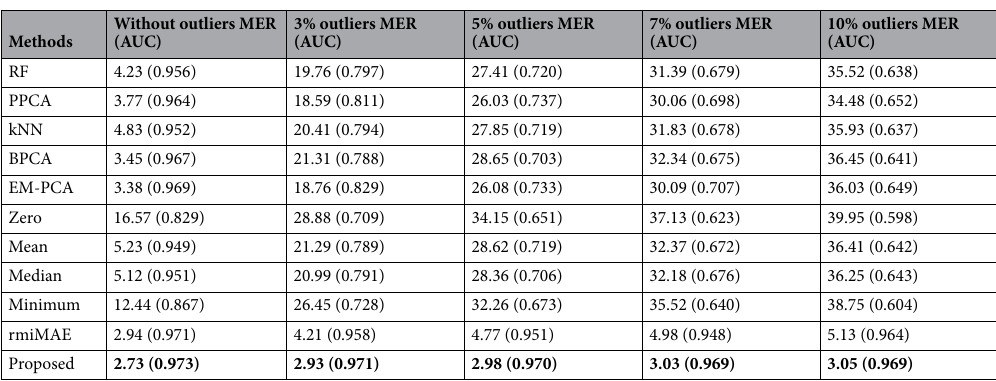
Table 1. Average misclassification error rate (MER) and area under the receiver operating characteristic curve (AUC) of DE calculation for two class simulated data with 5% missing values and different rates of outliers. Bold indicates the lower MER and Higher AUC throughout the